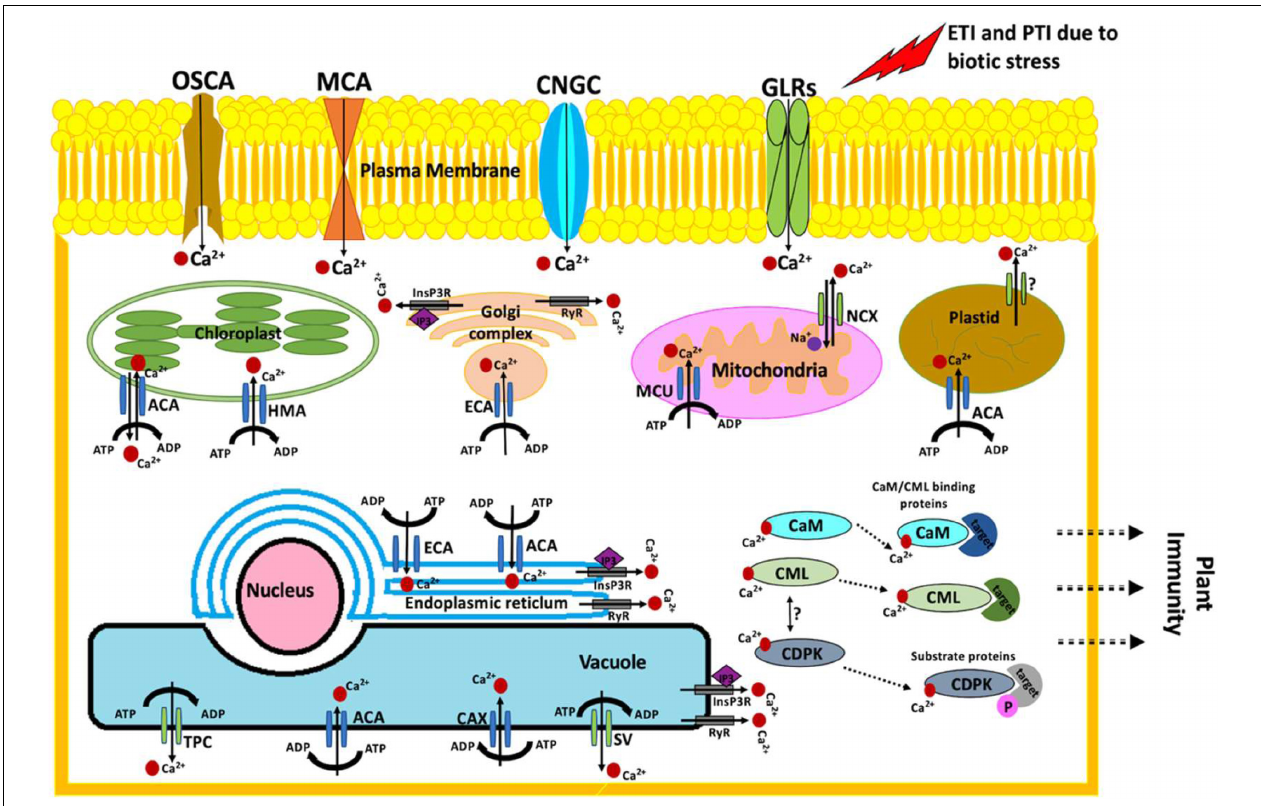
FIGURE 1 | Schematic representation of biotic stress perception and Ca 2 + signaling for the regulation of plant immune responses. The cytosolic Ca 2 + levels increase ( > 200 nM) upon perceiving biotic stress: calcium (Ca 2 + ), Ca 2 + –dependent protein kinases (CDPKs), calmodulin (CaM), calmodulin-like protein (CML), autoinhibited Ca 2 + -ATPases (ACAs), ER-type Ca 2 + -ATPases (ECAs), mitochondrial Ca 2 + uniporter (MCU), P1-ATPases (e.g., HMA1), Ca 2 + exchangers (CAX), two-pore channel (TPC), cyclic nucleotide-gated channels (CNGCs), glutamate receptor-like channels (GLRs), stretch-activated Ca 2 + channels (OSCAs), MID1-complementing activity (MCA), phosphate (P), adenosine triphosphate (ATP), adenosine diphosphate (ADP), 1,4,5-trisphosphate receptor-like channel (InsP 3 R), 1,4,5-trisphosphate (IP 3 ), cyclic ADP-ribose (cADPR)-activator ryanodine receptor-like channel (RyR), slow-activating vacuolar channel (SV), and sodium-calcium exchanger